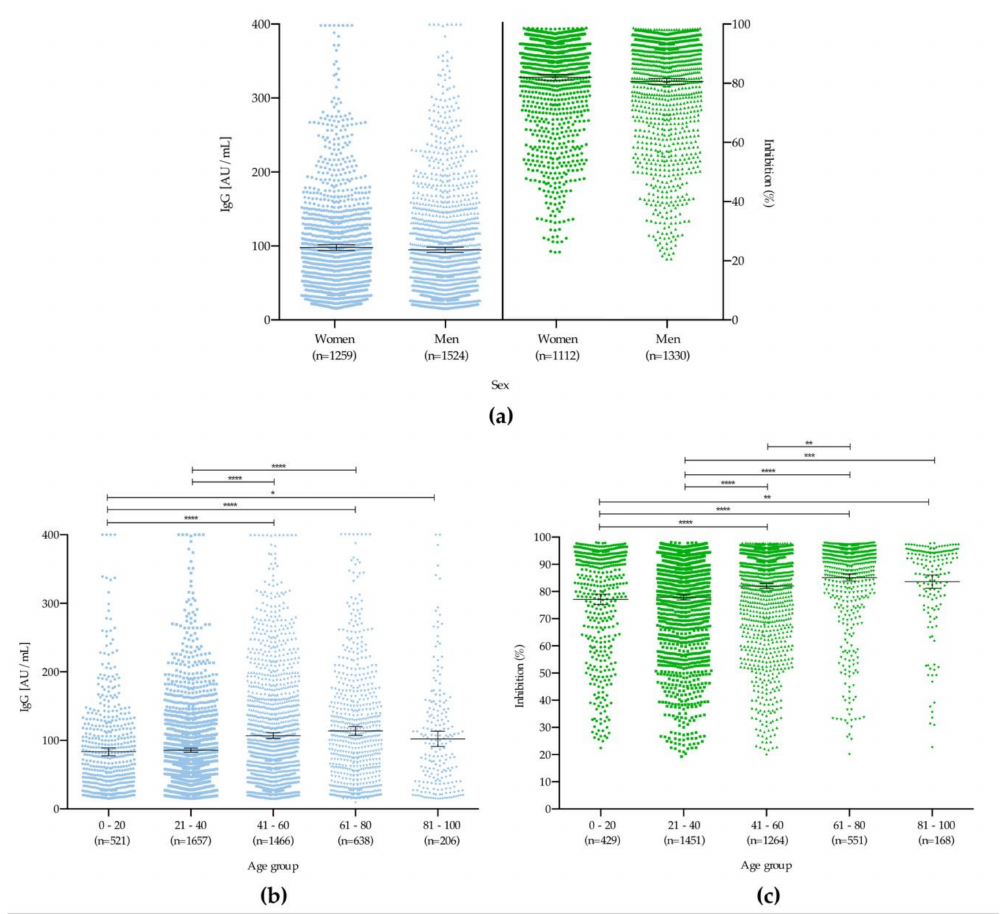
Figure 6. Comparative analysis of IgG concentration and neutralizing capacity against RBD. ( a ) male and female patients and ( b , c ): different age groups. * p < 0.05, ** p < 0.01, *** p < 0.001, **** p < 0.0001.